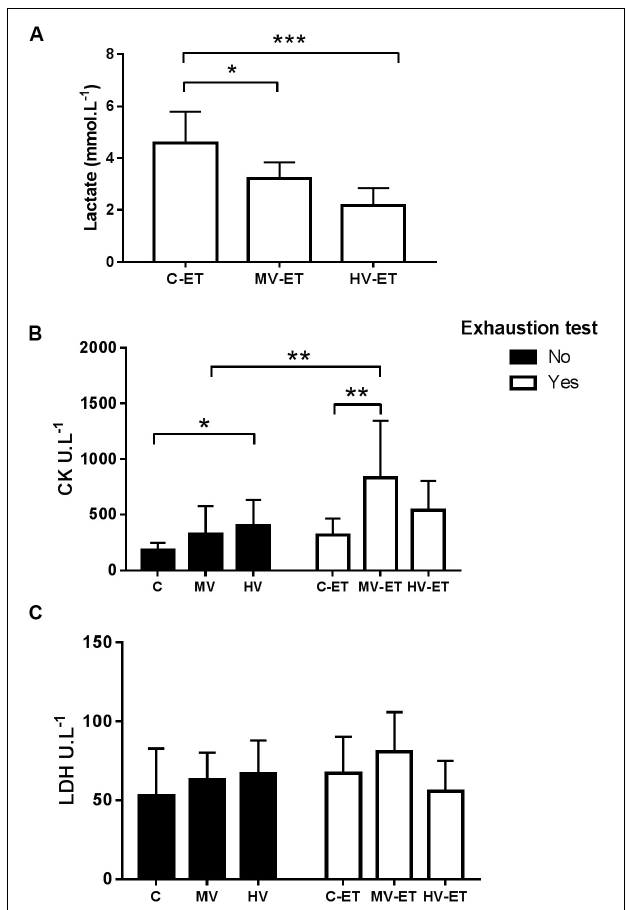
FIGURE 3 | Serum levels of Lactate, Creatine Kinase and Lactate dehydrogenase. (A) Lactate: MV-ET vs. C-ET ( P = 0.015); HV-ET vs. C-ET ( P < 0.001). (B) CK: Creatine Kinase; C-ET ( P = 0.026) and MV ( P = 0.033) vs. MV-ET. HV vs. C ( P = 0.015). (C) LDH: Lactate dehydrogenase. C, control group; C-ET, control + exhaustion test group; MV, moderate-volume group; MV-ET, moderate-volume + exhaustion test group; HV, high-volume group; HV-ET, high-volume + exhaustion test group. * P ≤ 0.05; ** P < 0.01; *** P < 0.001. Values represent mean ± S.D. All the experiments were carried out in triplicate.